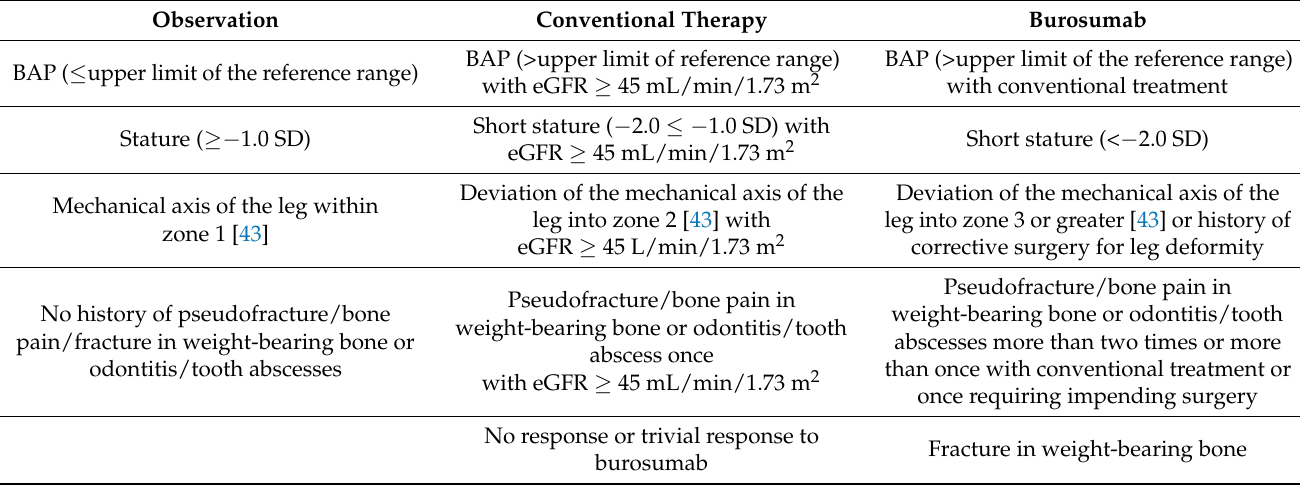
Table 1. Suggested indication and selection of therapy for adult XLH